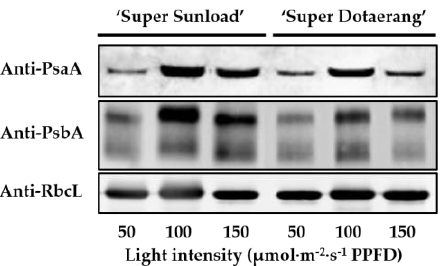
Figure 6. Expressions of PsaA and PsbA protein in ‘SD’ and ‘SS’ grafted onto the ‘B-Blocking’ rootstock. Equal loading was verified by the Rubisco large subunit (RbcL) level.